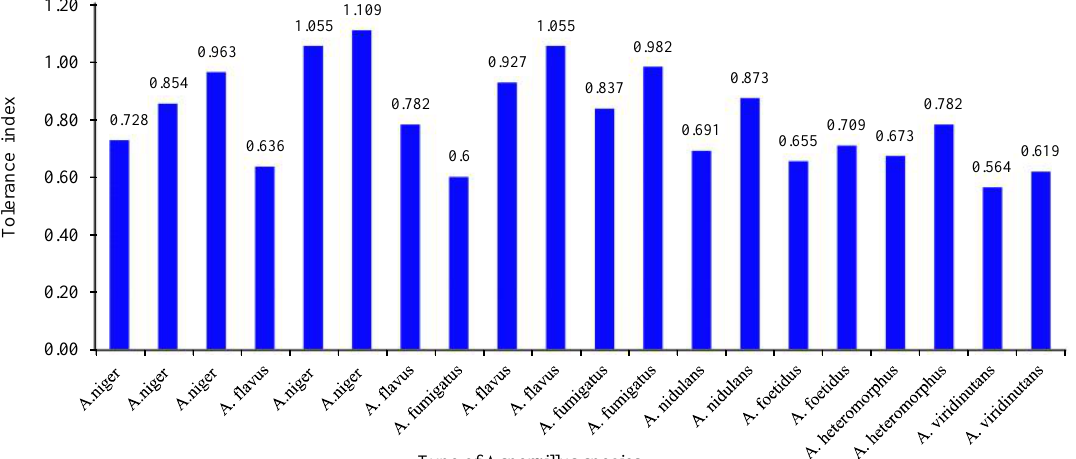
Fig. 5: Tolerance index (TI) of Aspergillus